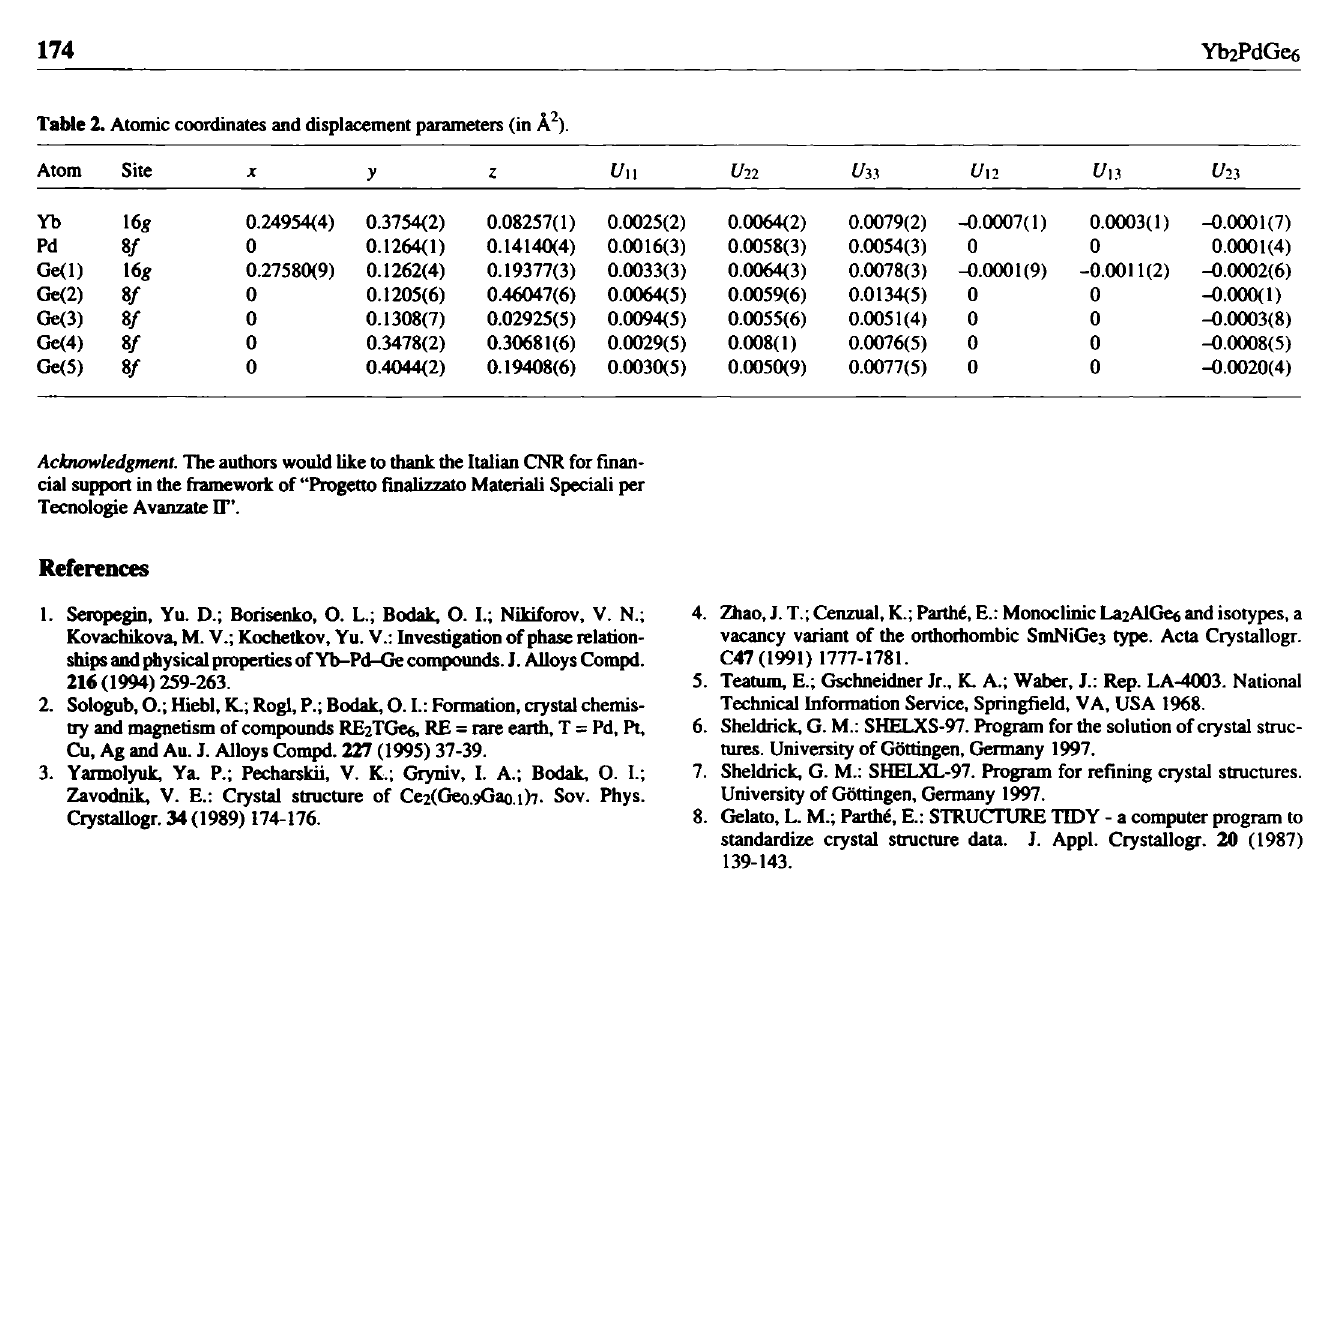
Table 2. Atomic coordinates and displacement parameters (in À 2